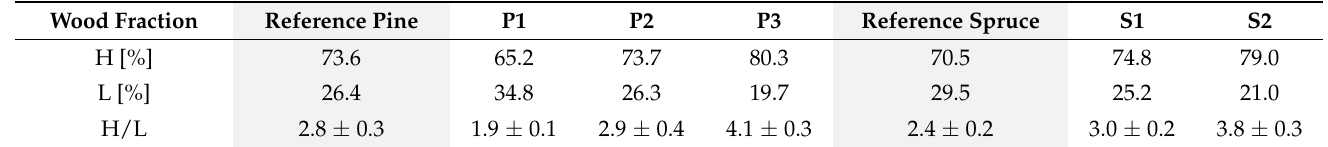
Table 2. Wood composition determined by Py-GC-MS, where H-holocellulose, L-lignin and H/L ratio. Wood Fraction Reference